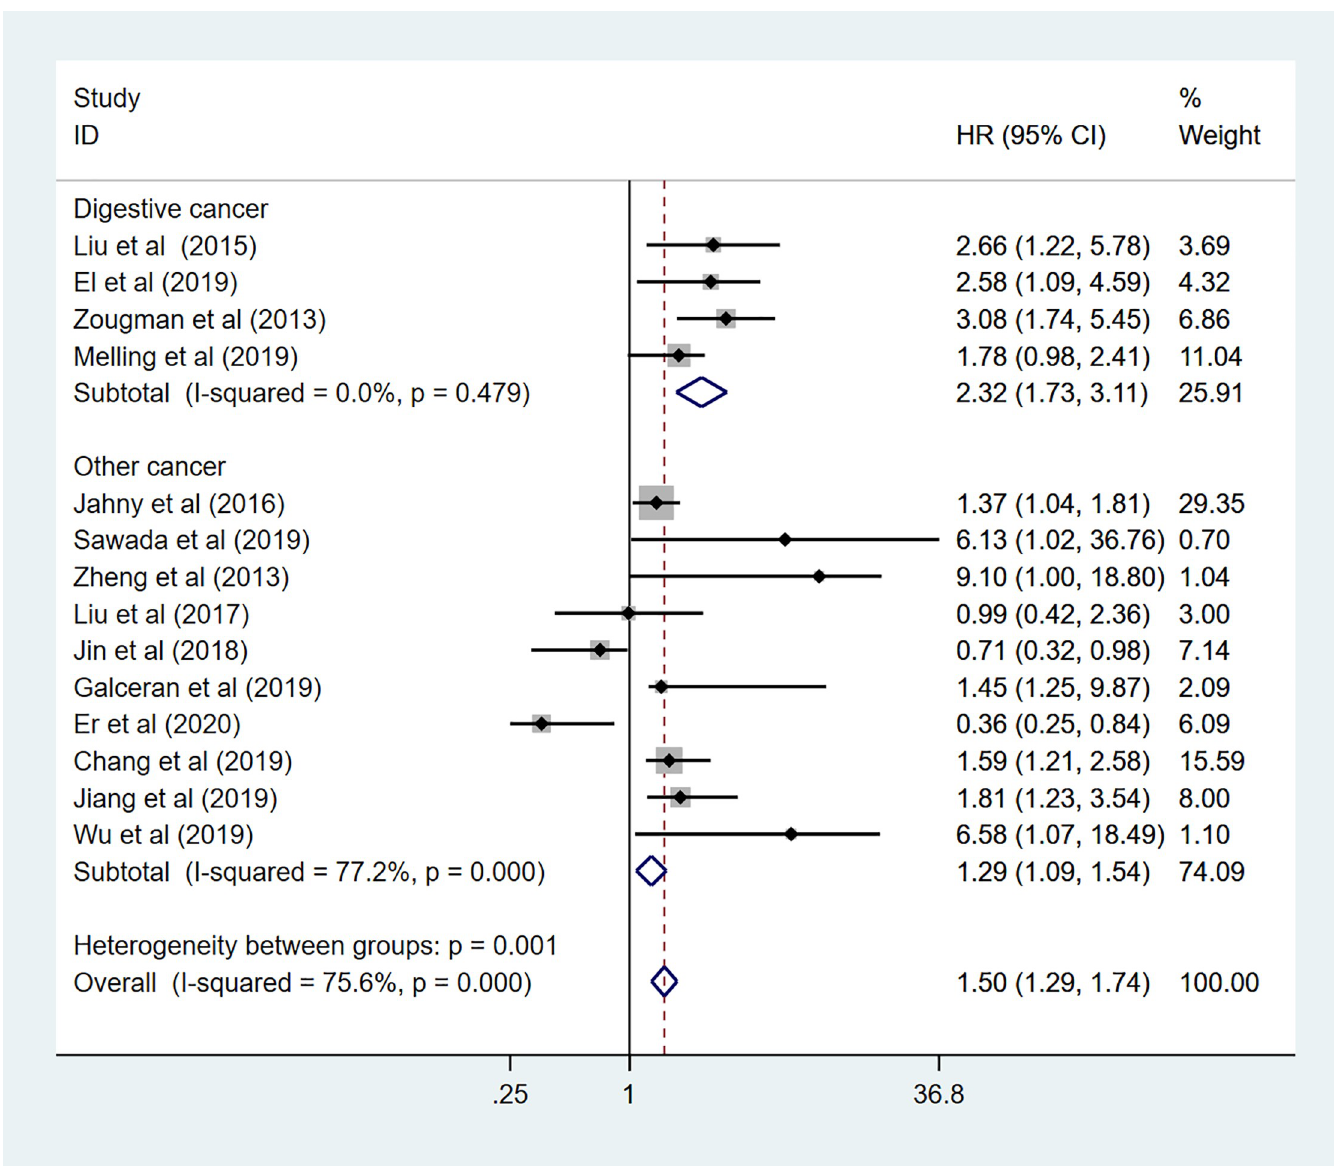
Fig 6. Forest plot for the subgroup analysis. Digestive